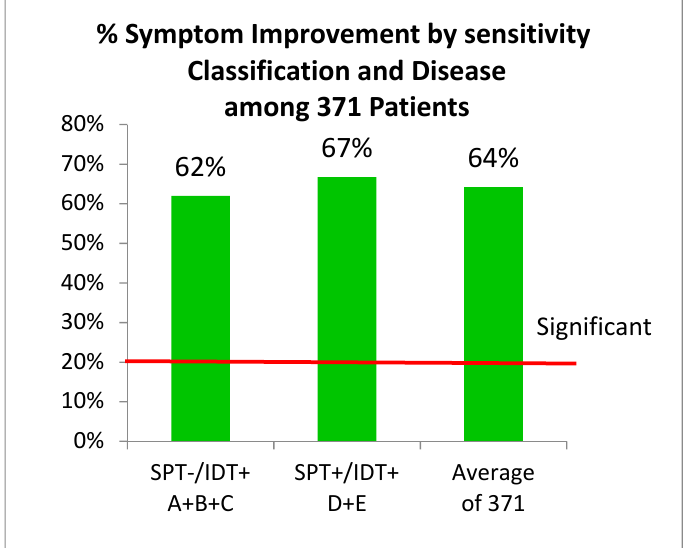
Figure 4. Symptom improvement by allergen sensitivity in 371 patients. A significant improvement is >20% [12]. The two groups are not statistically different.